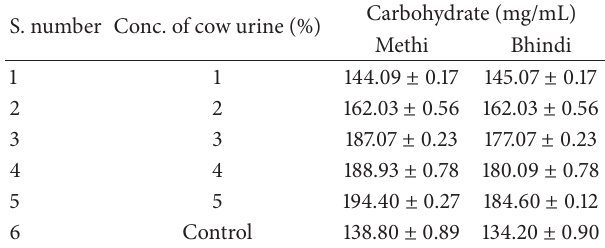
Table 5: Carbohydrate estimation of Trigonella foenum-graecum (Methi) and Abelmoschus esculentus (Bhindi) sprayed with different concentrations of cow